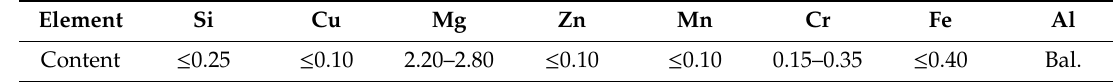
Table 2. Chemical composition of AA5052 aluminum alloy (wt.%).